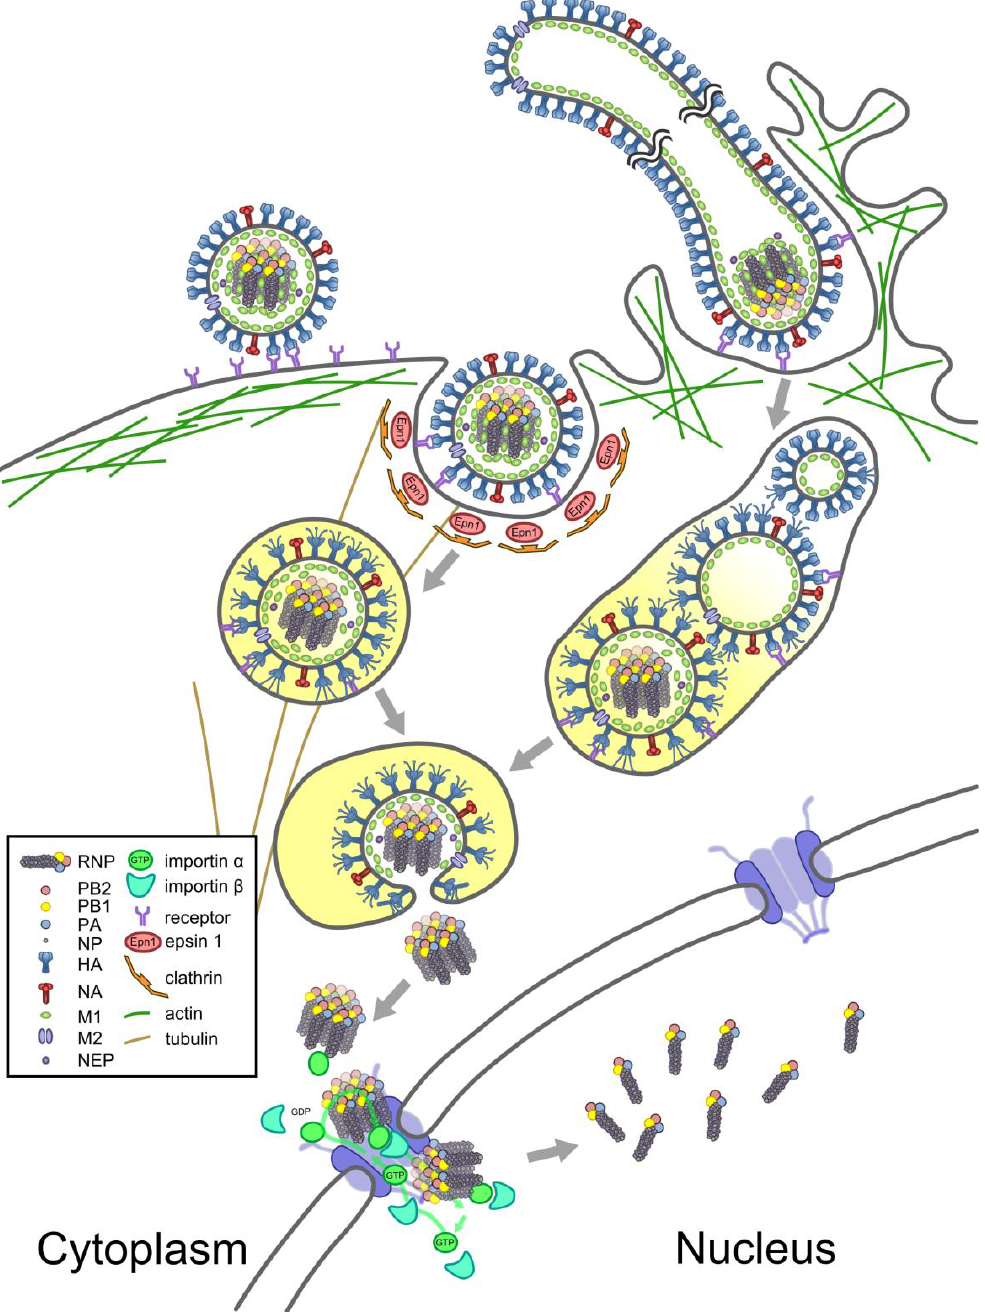
Figure 3. Transport of an RNP from virion to nucleus. Schematic showing viral entry and the passage of RNPs to the nucleus. Spherical ( left ) and filamentous ( right ) virions bind to sialic-acid bearing receptors on the cells surface and are imported by clathrin-mediated endocytosis ( left ) or macropinocytosis ( right ). The increasing acidity of their environment (indicated by yellow shading) results in conformational changes in M2, causing filaments to fragment ( right ). Changes in pH are transmitted through M2 to the virion interior, where they cause M1 to dissociate from RNPs. The increasing acidity also causes conformational changes in HA, which inserts into the endosomal membrane and mediates membrane fusion, expelling a complex of uncoated RNPs into the cytoplasm. The complex of RNPs interacts with the classical nuclear import pathway and dissociates in the nucleus ( bottom ). See text for